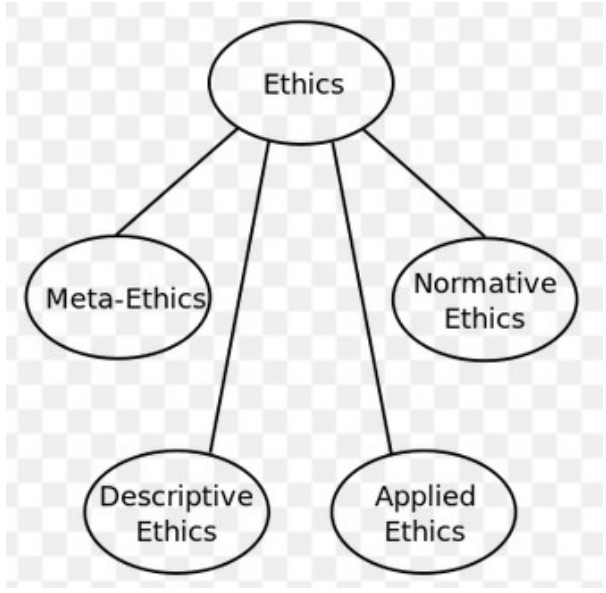
Figure 1. Branches of ethics. Source: https://commons.wikimedia.org/wiki (/File:Ethics-en.svg).